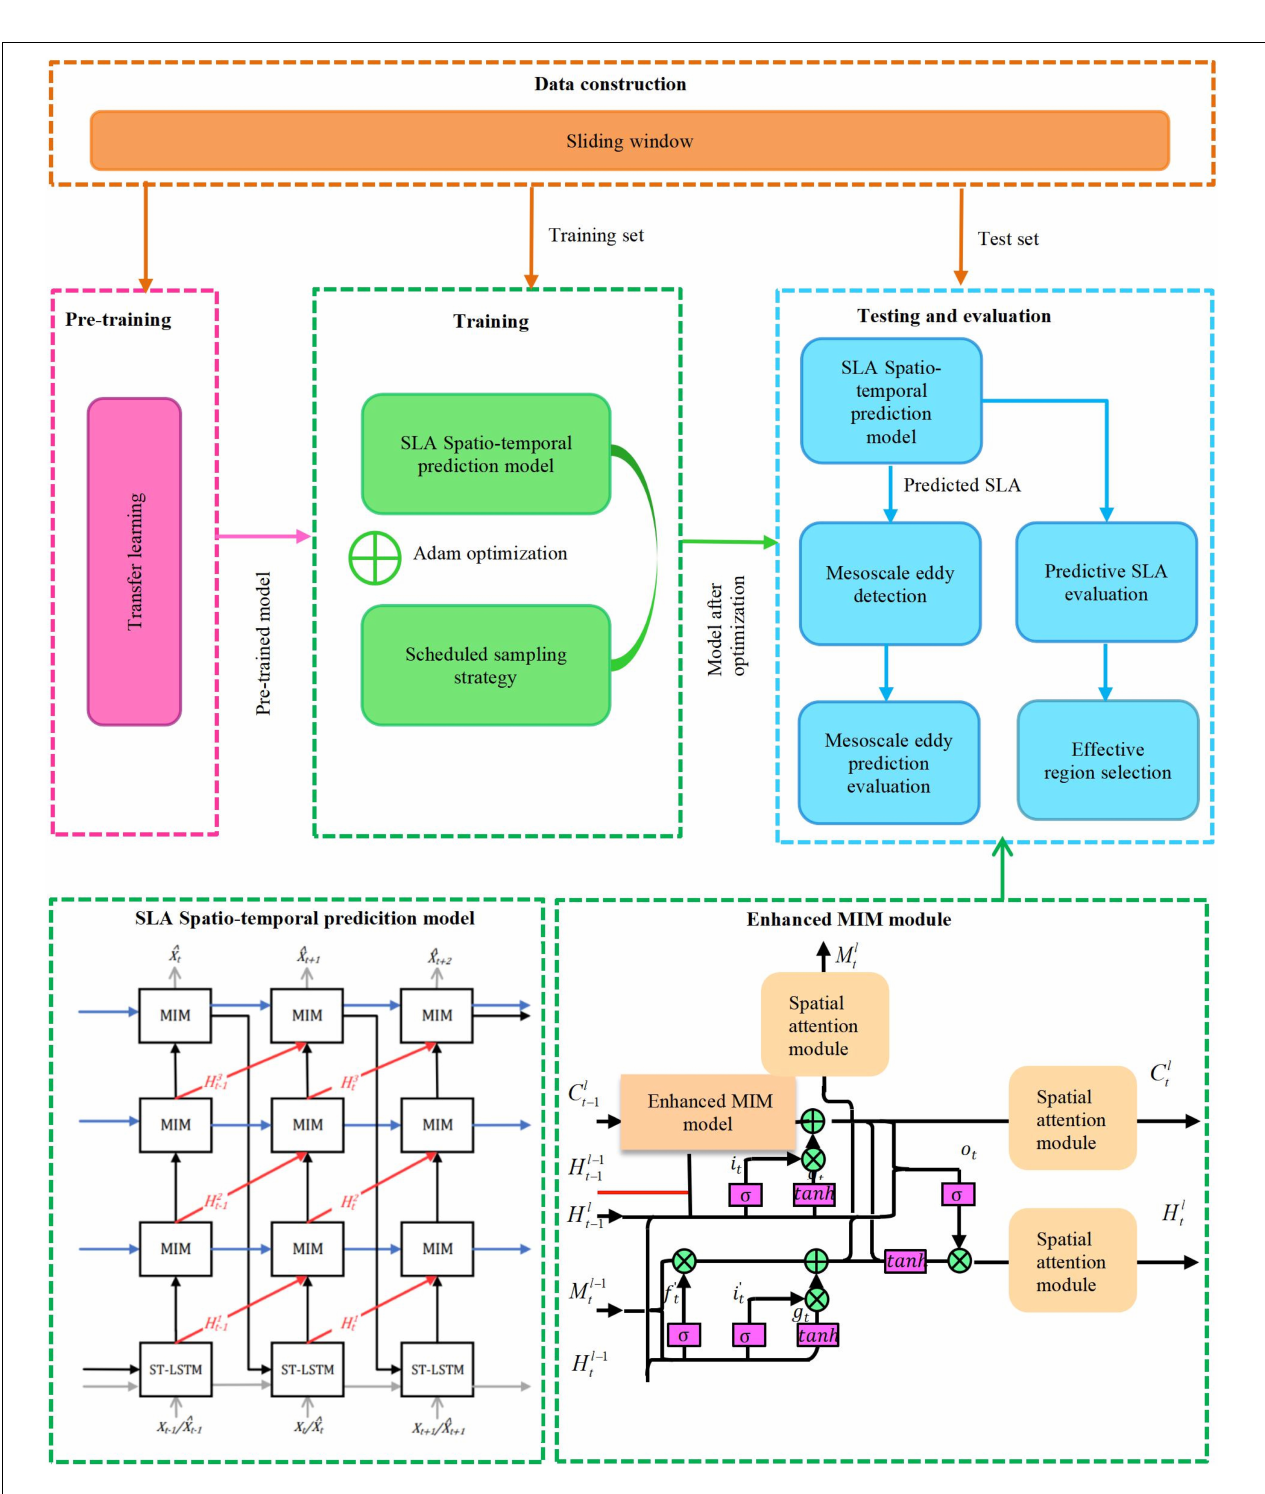
FIGURE 1 | Overall flow chart of the mesoscale eddy prediction system.